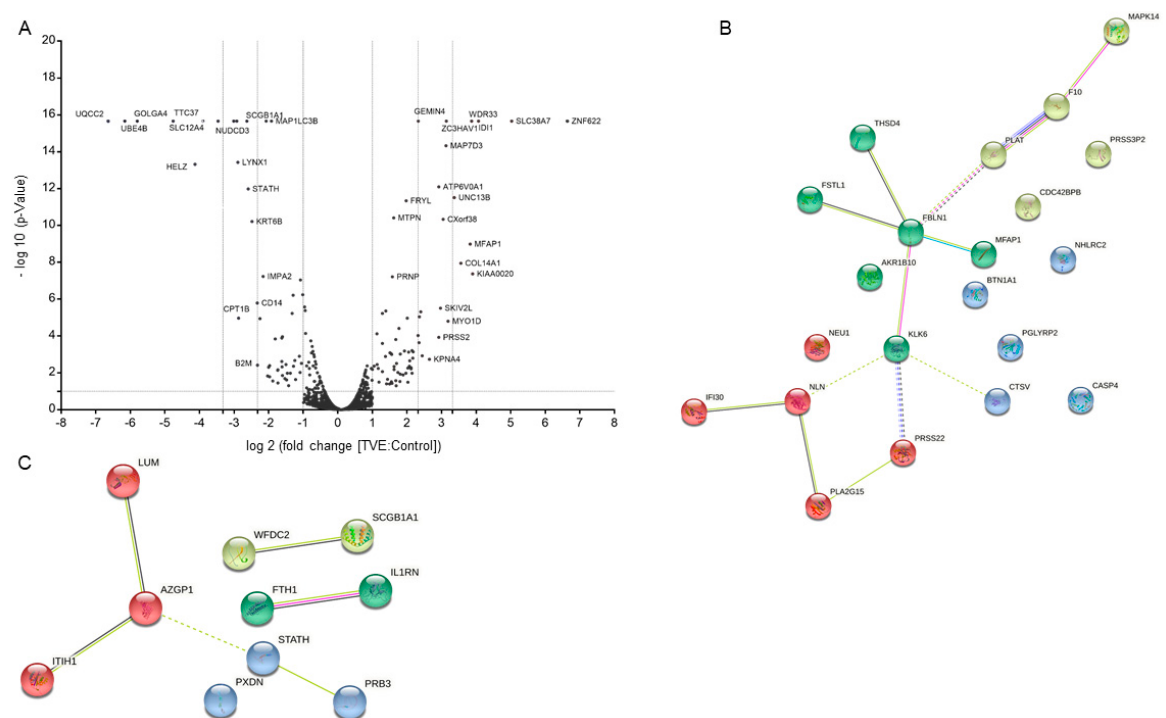
Figure 4. ( A ) Volcano plot of significance vs. fold change of TVE vs. control proteins. STRING analysis of TVE more abundant ( B ) and less abundant ( C ) proteins annotated as being extracellular ones by PD. The four clusters are shown in different colors. Each protein is labeled through its gene name. Table 1. List of the significantly quantified proteins whose “cellular component” is annotated to be “extracellular.” Each protein is reported with its accession, gene name, TVE vs. control abundance ratio, and the related p -value.